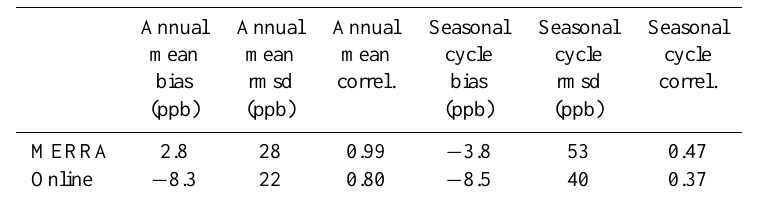
Table 10. CO evaluation against NOAA/GMD